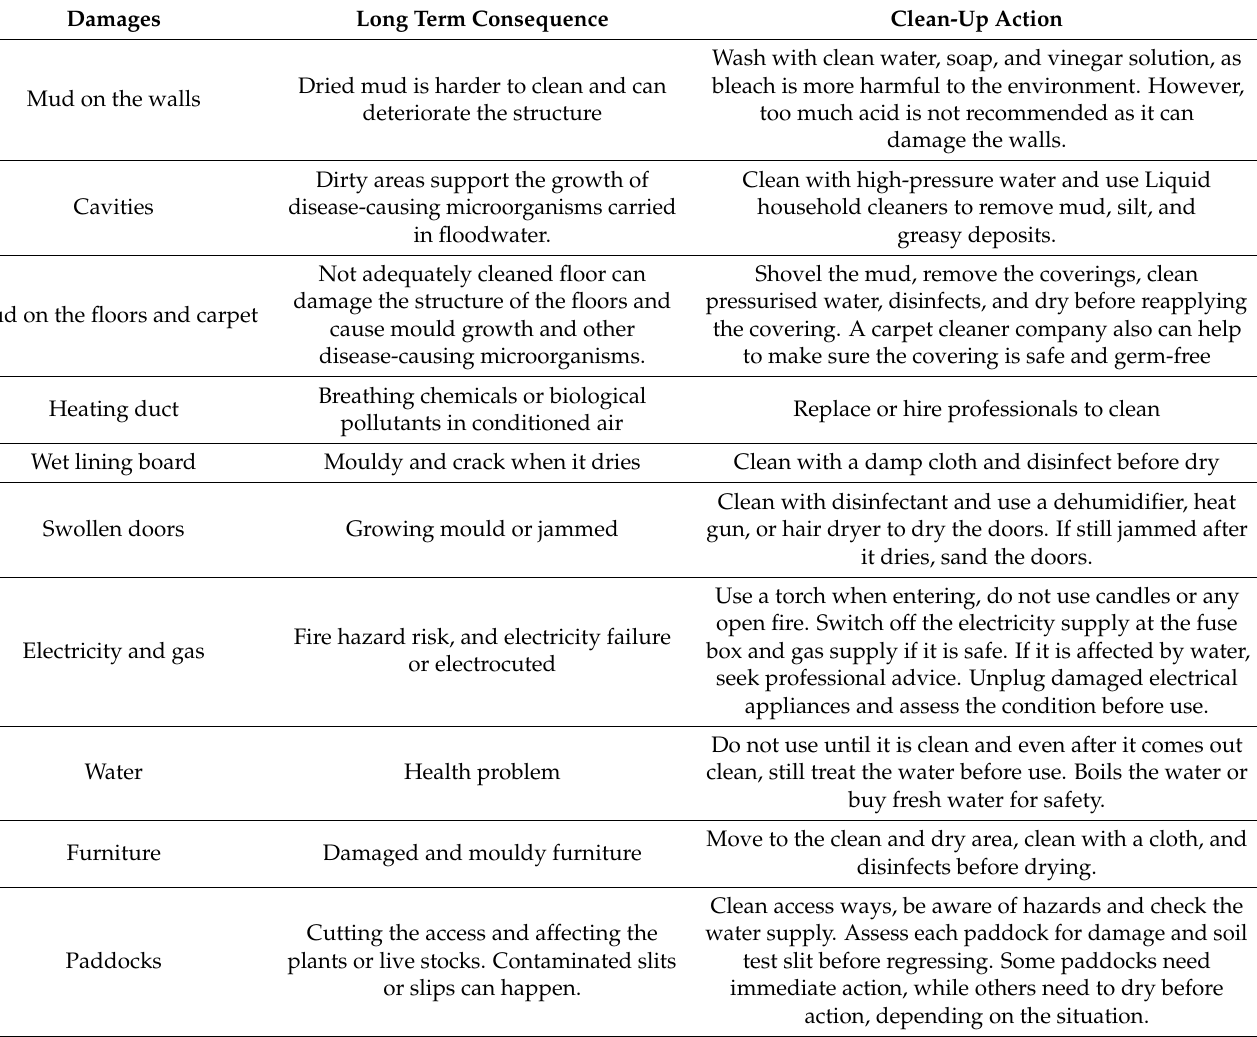
Table 2. Usual flood damages in property in Northland and cleaning process (Source: BRANZ [62] modified and combined with research data collected in July